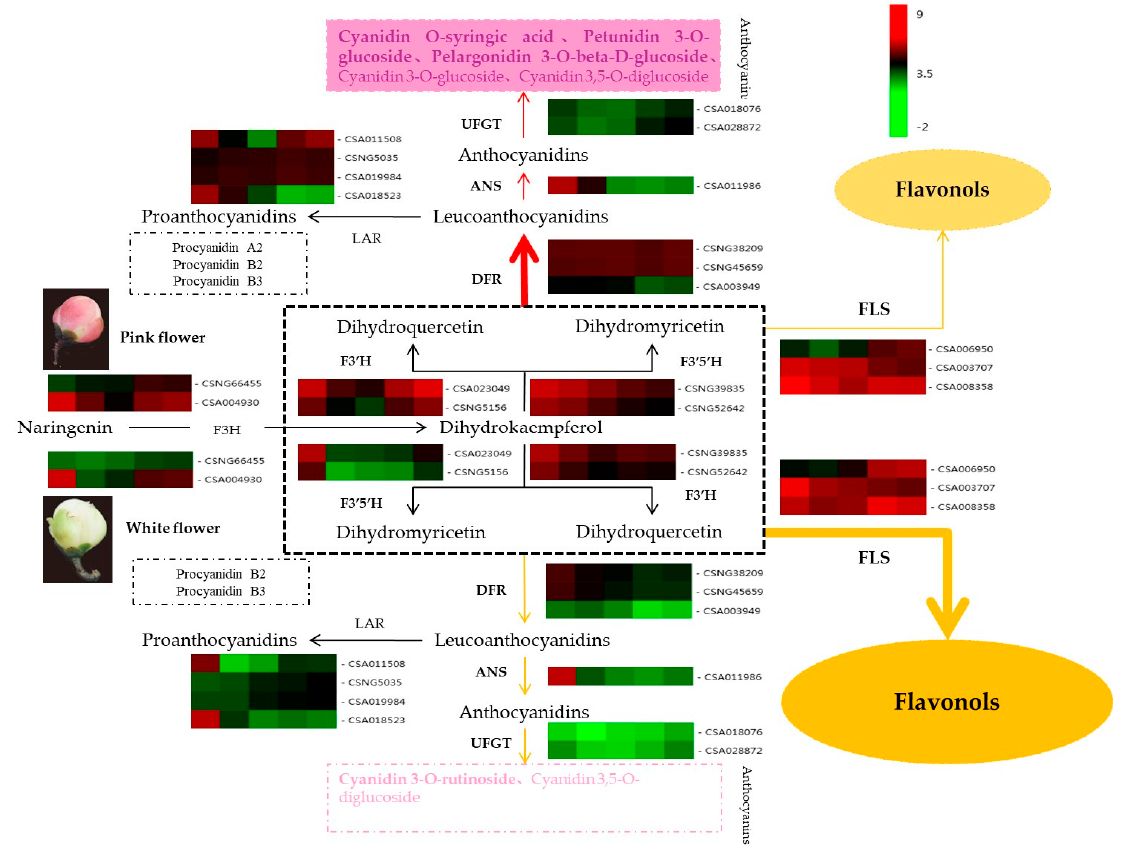
Figure 8. Tea flower unigenes thought to be incorporated in the anthocyanin biosynthetic pathway and their genes expression levels. The heatmap is created according to the average expression levels of related biosynthetic genes based on FPKM value. A color bar is presented at the top right. Green indicates low expression, and red indicates high expression. DFR gene variants were all significantly upregulated in pink flowers relative to white flowers. DFR is responsible for catalyzing the transformation of dihydroquercetin and dihydromyricetin into leucoanthocyanidins, which are upstream precursors to anthocyanins in the anthocyanin biosynthetic pathway. The significant upregulation of three DFR genes indicates that flavonoid metabolism in purple flowers shunts more substrate than white flowers into the anthocyanin biosynthesis pathway. Likewise, qRT-PCR revealed that in white flowers high FLS activity shunted substrate away from the anthocyanin pathway into the flavonol biosynthesis pathway. The relatively high FLS activity may explain the white coloration in ZJW flowers, while the relatively high DFR activity may explain the pink coloration in in BTP flowers. Abbreviations are as follows: DFR (dihydroflavonol reductase); F3H (flavanone-3-